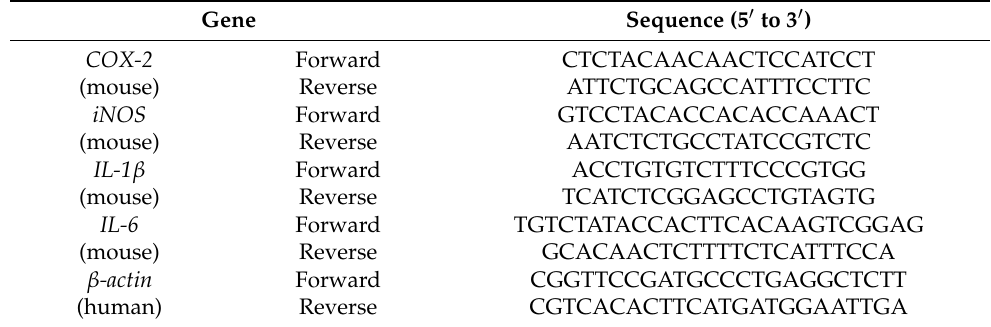
Table 1. Primer sequences for real-time